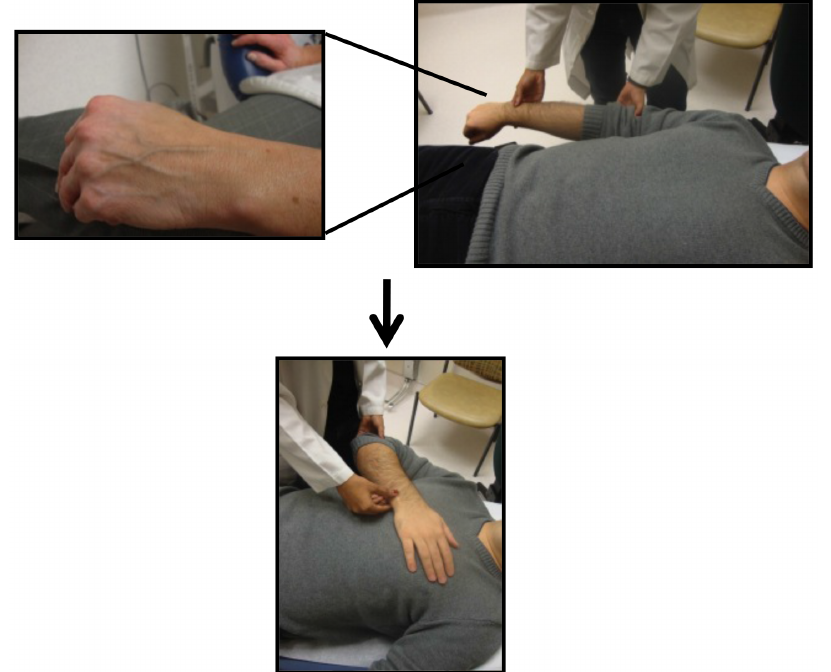
Figure 3. Assessment of Peripheral Venous Collapse; the Anthem sign. waveforms relative to the sternal angle (Figure 1). CVPs are considered elevated when the height of the venous column is . 3 cm above the sternal angle [11]. The right internal jugular vein